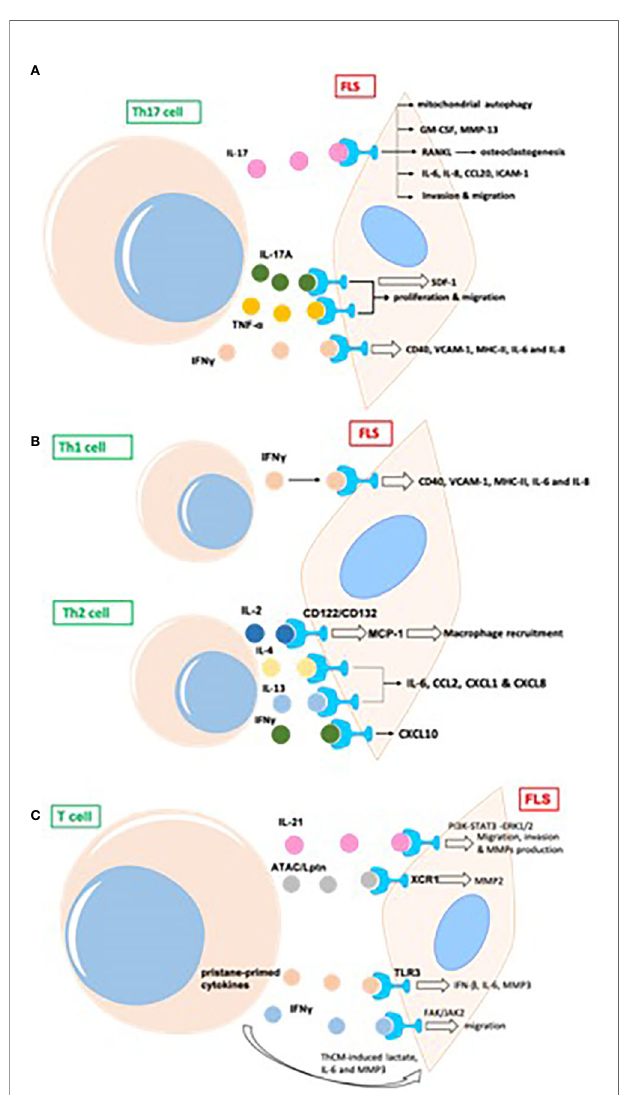
FIGURE 3 | T cells promote in fl ammatory phenotype of FLS in RA, mainly including proliferation, migration, invasion, and production of proin fl ammatory cytokines and destructive MMPs in joint synovium. (A) The indirect effects of Th17 cells on FLS in RA; (B) The indirect effects of Th1/Th2 cells on FLS in RA; (C) The indirect effects of other T cells on FLS in RA. GM-CSF, granulocyte- macrophage colony-stimulating factor; MMP, matrix metalloproteinase; RANKL, receptor activator of NF- k B ligand; TRAF, TNF receptor-associated factor; AP, activator protein; ICAM, intercellular adhesion molecule; MIF, migration inhibitory factor; ATAC, activation-induced, T cell-derived, and chemokine-related cytokine; Lptn, lymphotactin; FAK,focal adhesion